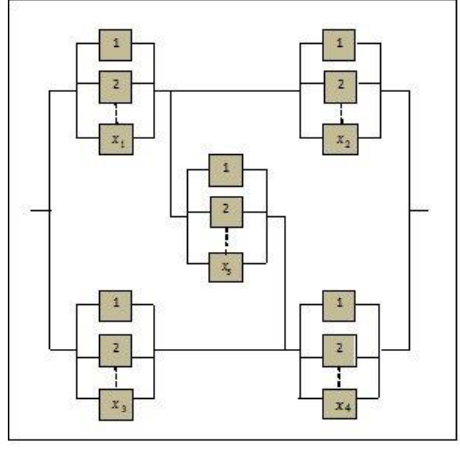
Fig. 1. A complex bridge